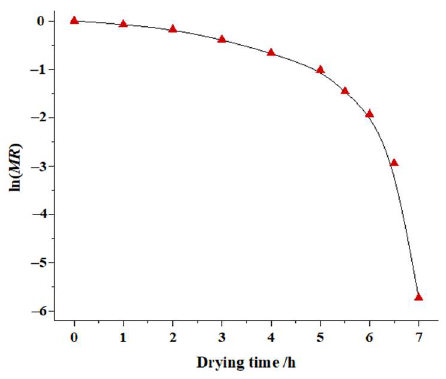
Figure 3. Plot of ln ( MR ) versus drying time.